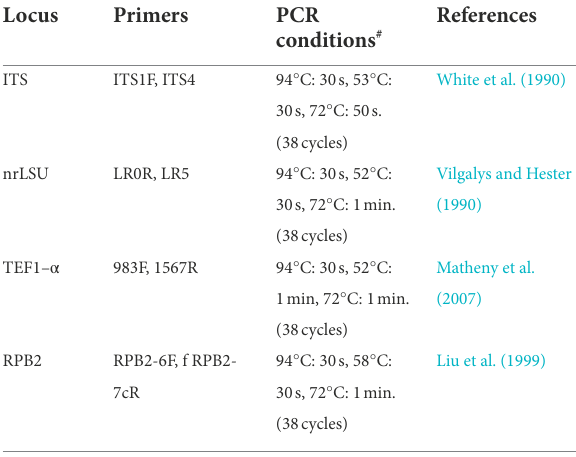
# The three steps given for each primer pair were repeated for 38 cycles, preceded by an initial denaturation step of 5 min at 94 ° C, and followed by a final elongation step of 10 min at 72 ° C and a final hold at 4 °